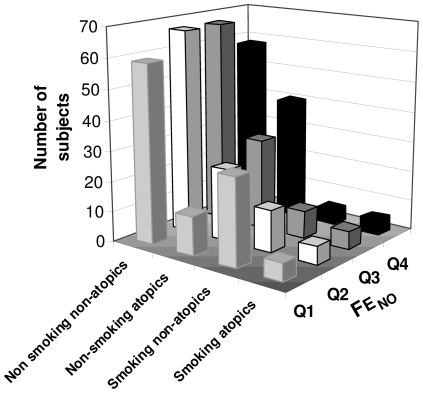
Number of subjects in each FENO quartile (FENO Q1–Q4) for non-smoking non-atopics, non-smoking atopics, smoking non-atopics and smoking atopics, respectively.